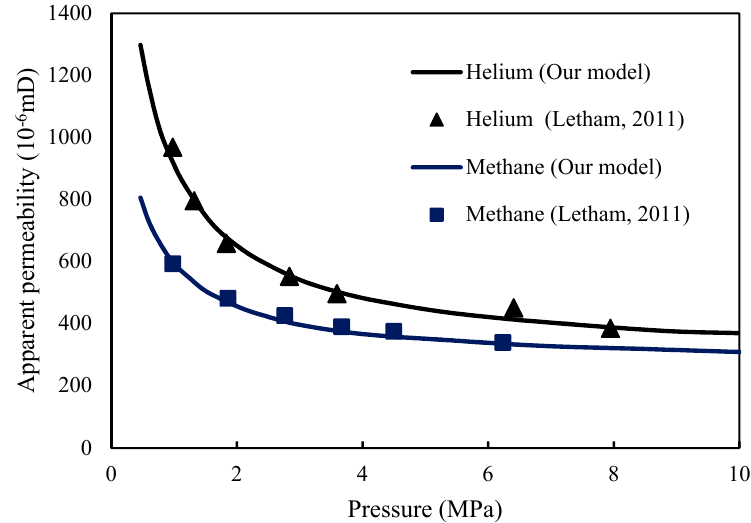
Figure 3. Comparison of apparent permeability calculated by the model in this paper with experimental data.